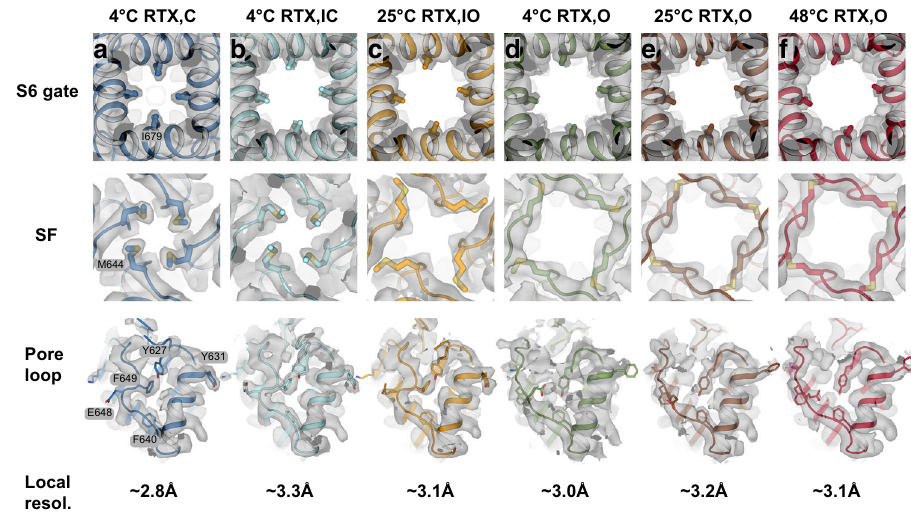
Fig. 4 Pore comparison across TRPV1 C, RTx , TRPV1 IC, RTx , TRPV1 IO, RTx , and TRPV1 O, RTx . The cryo-EM densities (grey surface) and respective models (cartoon) depicting bottom-up views of the S6 gate (top), top-down views of the selectivity fi lter (middle), top-down views of the monomeric outer pore (bottom), and local estimated resolutions for TRPV1 C, RTx a , blue, thresholding 0.12); TRPV1 IC, RTx b , cyan, thresholding 0.035); TRPV1 IO, RTx c , orange, thresholding 0.09); TRPV1 O,RTx,4°C d , green, thresholding 0.1); TRPV1 O,RTx,25°C e , brown, thresholding 0.08); and TRPV1 O,RTx,48°C f , red, thresholding